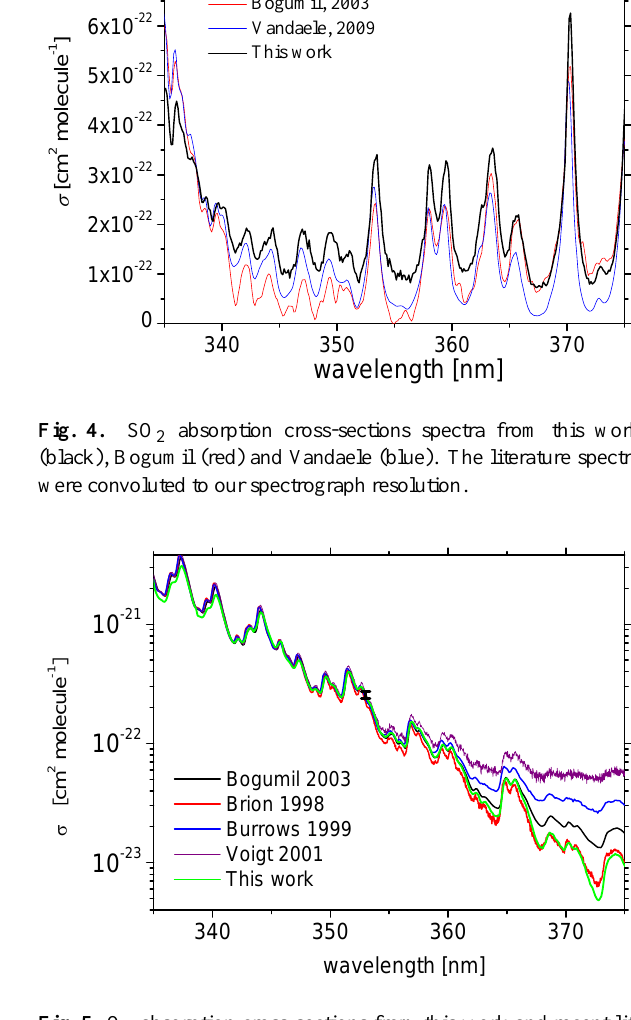
Fig. 5. O 3 absorption cross-sections from this work and recent lit- Figure 5. O 3 absorption cross-sections from this work and recent literature spectra (Voigt 3 erature spectra (Voigt et al., 2001; Burrows et al., 1999; Bogumil et et al., 2001; Burrows et al., 1999; Bogumil et al., 2003; Brion et al., 1998). The standard 4 al., 2003; Brion et al., 1998). The standard deviation of literature cross-sections at 353nm is indicated by an error deviation of literature cross-sections at 353 is indicated by an error bar. 5